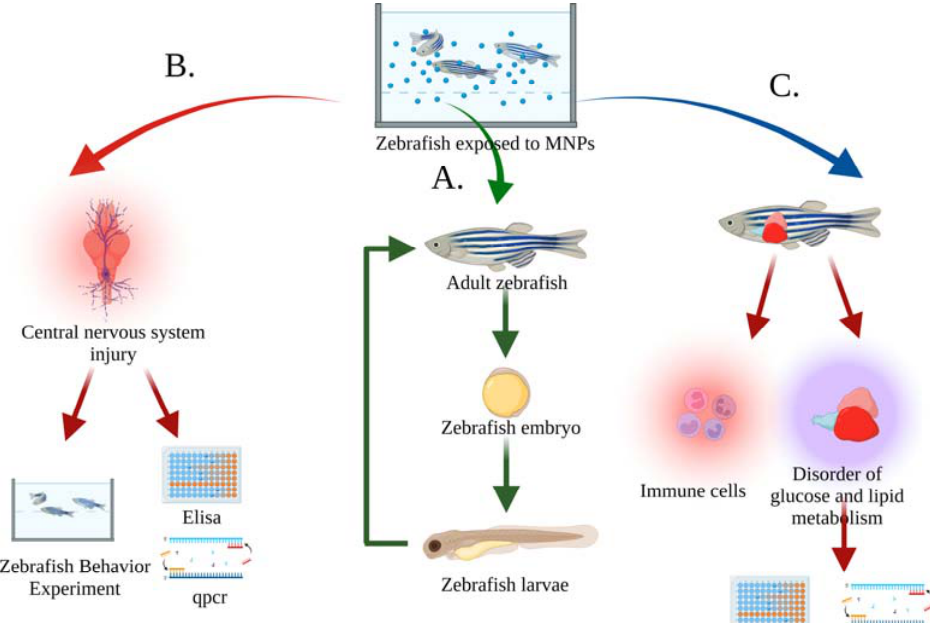
Figure 3. Evaluation index of MNP toxicity in zebrafish in a water body. ( A ) Evaluation of the toxicity of MNPs on growth and reproduction by the damage and apoptosis of sperm, testis, and oocytes of adult zebrafish, as well as the increased rate of malformation and mortality of embryos [40–42]; ( B ) Evaluation of the behavioral and neurological toxicity of MNPs by increasing oxidative-stress level and apoptosis in the zebrafish brain, as well as behavioral experiments to detect memory, learning, and mental disorders in zebrafish [43–45]; ( C ) Evaluation of the toxicity of MNPs on the metabolism and immune system by the upregulation of immune-related gene expression and apoptosis, as well as the reduction of hepatic glucose and lipid metabolism, glucose, α -ketoglutarate, and lipid-related indicators [46–48].